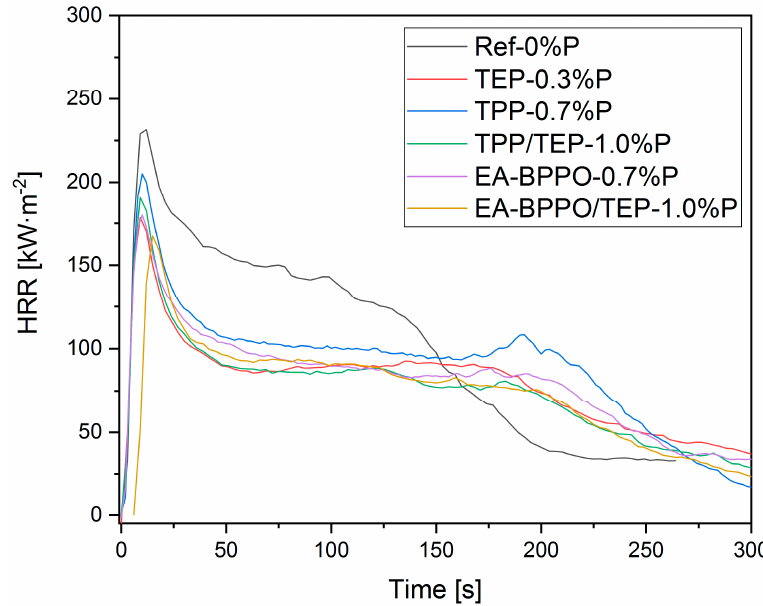
Figure 6. Heat release rate curves (average of three measurements) obtained by forced flaming combustion with heat flux 50 kW · m − 2 of control foams (Ref-0%P, TEP-0.3%P, TPP-0.7%P, and TPP / TEP-1.0%P) as compared to the foams EA-BPPO-0.7%P and EA-BPPO / TEP-1.0%P.